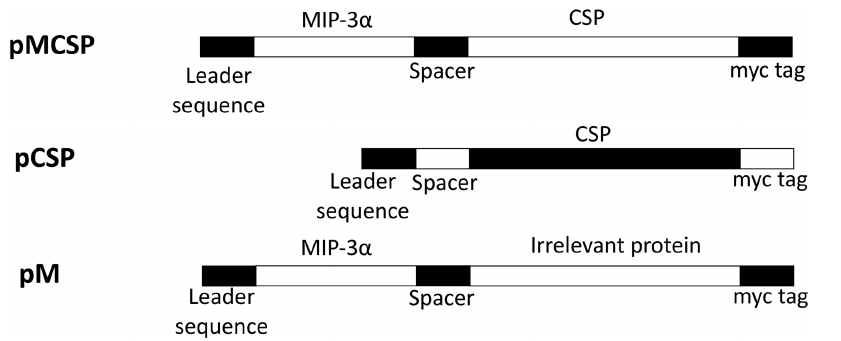
Figure 1. Diagrammatic representation of the DNA constructs, including control plasmids, used for immunization. The construct for P. yoelii used mouse MIP3 a , while the P. falciparum construct employed the sequence for human MIP3 a . M refers to MIP3 a . CSP refers to a segment of the Plasmodium yoelii circumsporozoite protein; and MCSP refers to the fusion protein of MIP-3 a and a segment of the P . yoelii circumsporozoite protein. Also shown are the positions of the leader sequence, spacer, and the myc tag. The leader sequence for the P. yoelii construct is the interferon– c induced protein 10 secretion leader sequence; the leader sequence for the P. falciparum construct is the human tissue plasminogen activator leader sequence [46]. The MCSP and hMfCSP nucleotide sequences are provided in the supplementary materials.